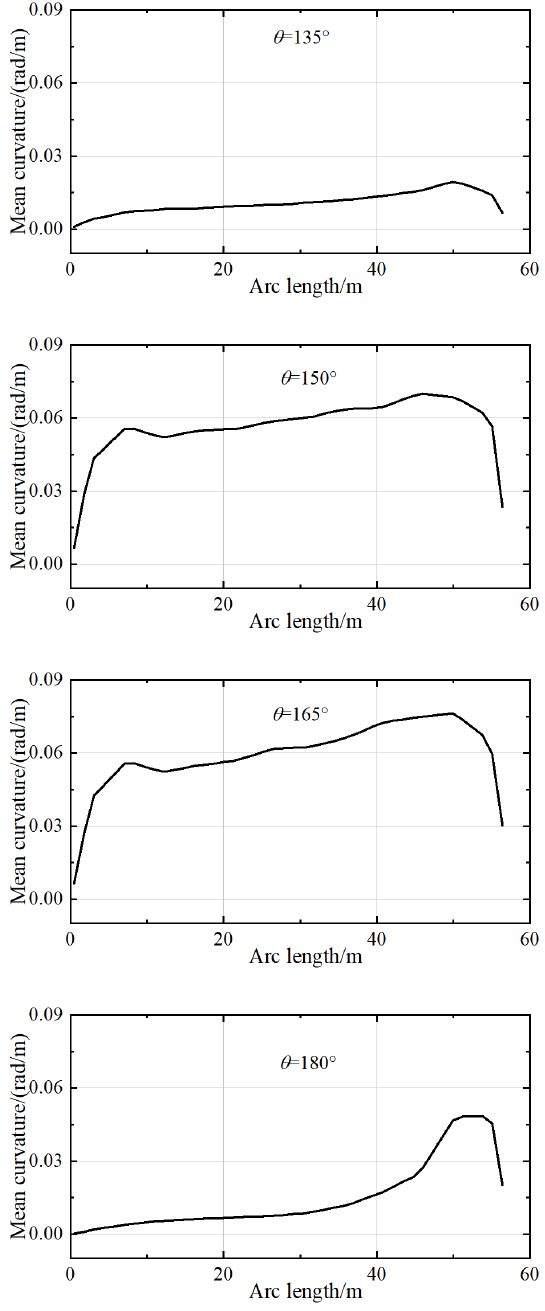
Figure 14. The mean curvature of the crane wire along the length direction.